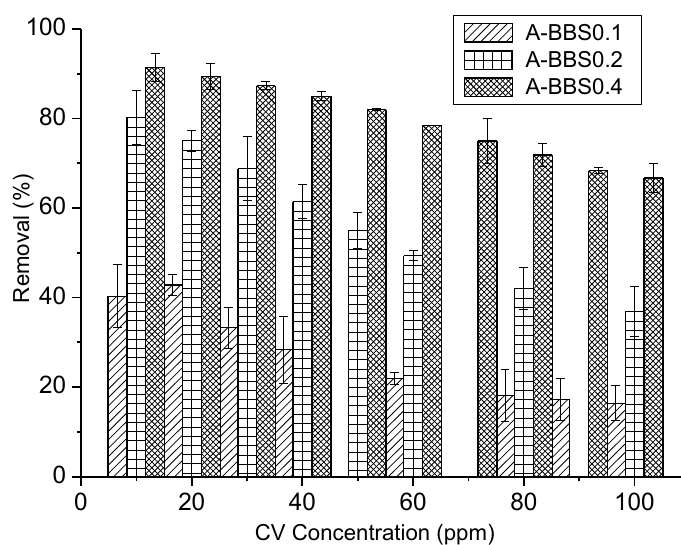
Figure 5. Adsorption % of dye CV by different hybrid adsorbents A -BBS0.4, A -BBS0.2, and A -BBS0.1, versus initial dye concentration at 15 °C.